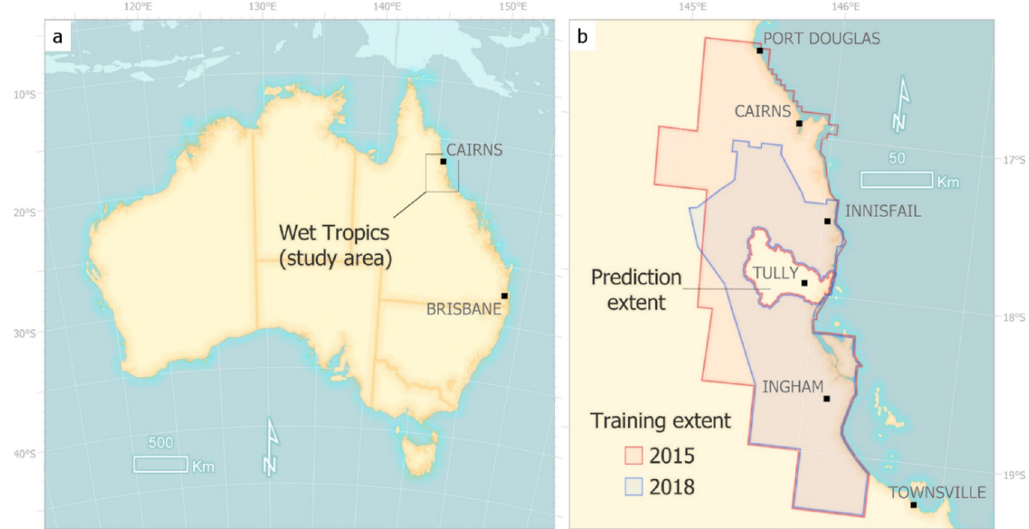
Figure 1. The study area ( a ) and extents of training ( b ). Note the Tully River catchment was excluded from the training and reserved as the extent of the final classification.